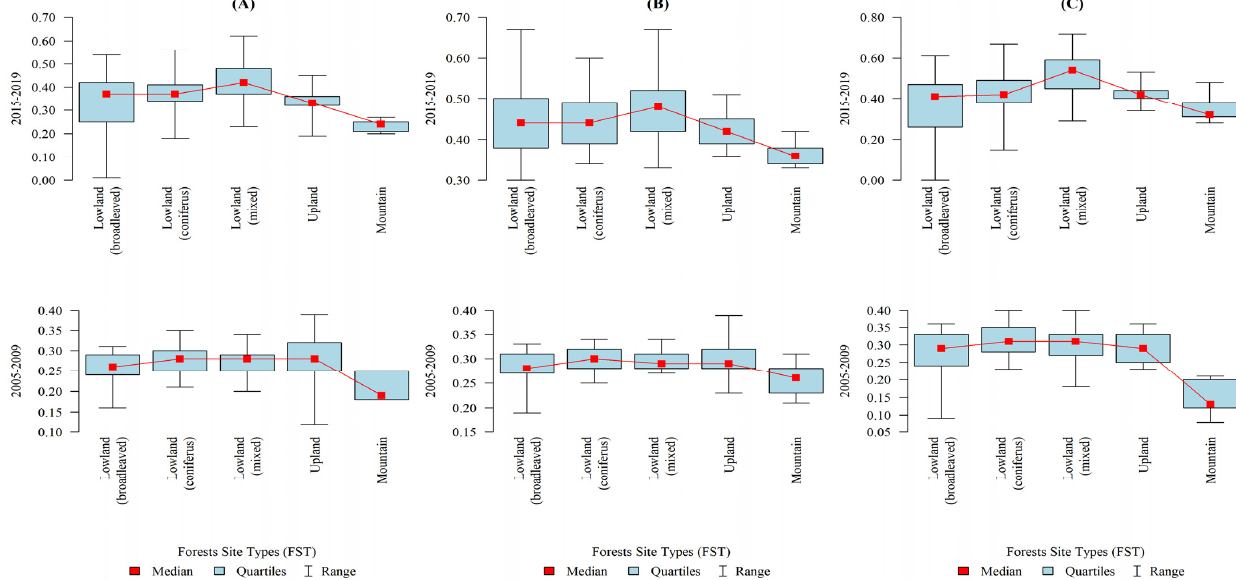
Figure 2. Ranges, medians, and quartiles of synthetic financial indicators 1, 2 and 3 for forest site types. ( A )